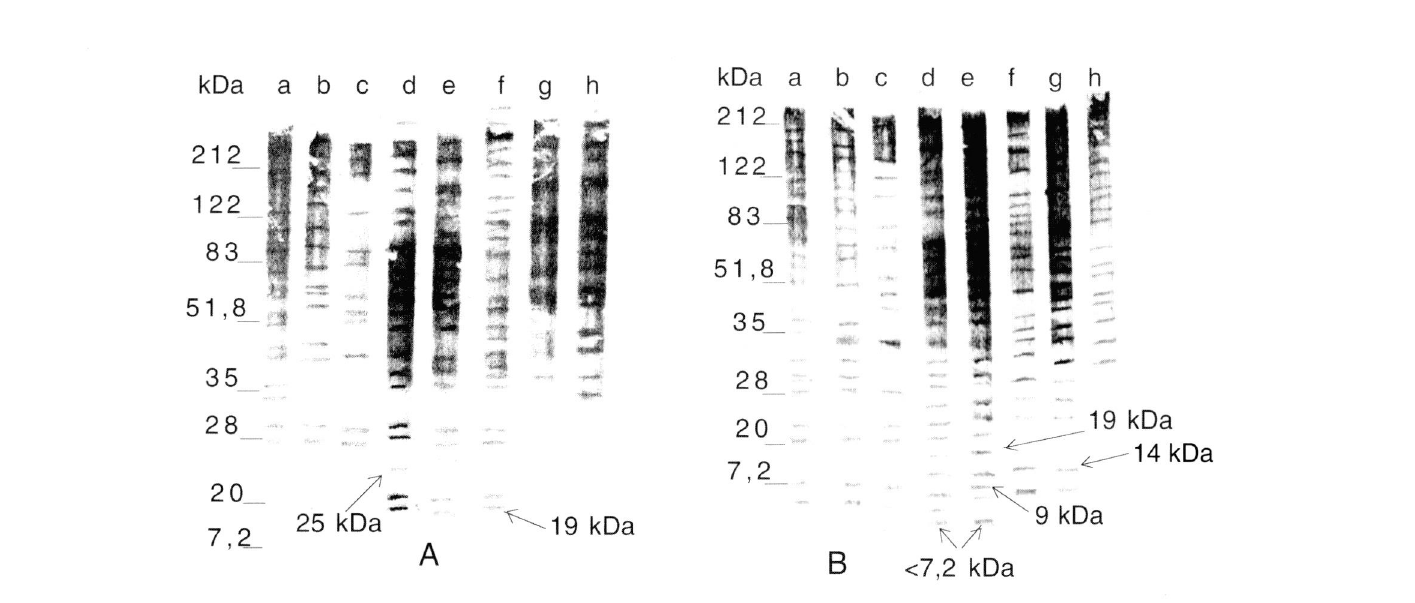
Fig. 1. - Cross-reactivity revealed by immunoblotting between Anisakis simplex s.l and other nematodes. A) Immunoblot of helminth extracts with anti-SA serum of A. simplex s.l. B) Immunoblot of helminth extracts with anti-ES serum of A. simplex s.l.: (lane a) Ascaris suum; (lane b) A. lumbricoides: (lane c) Toxocara canis; (lane d) A. simplex s.l. -SA-; (lane e) A. simplex s.l. -ES-; (lane f) A. physeteris; (lane g) Hys- terothylacium aduncum; (lane h) H. fabri. Arrows show specie-specific and genus-specific bands. The molecular weight markers are indi cated on the left.